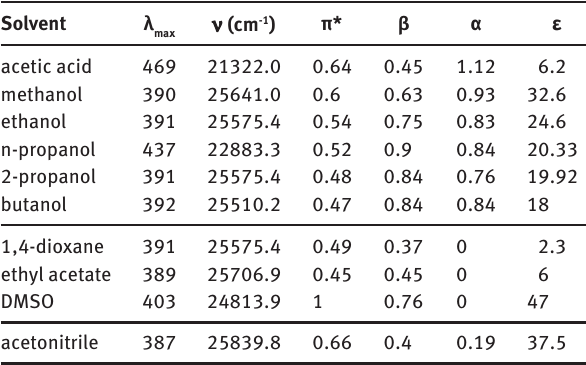
of 4-APAP as a function of solvent dielectric constant. Figure 17: Variation of λ max Table 3: Absorption maxima of azo compound in various solvents and selective Kamlet-Taft solvent parameters (ε: dielectric constant) for